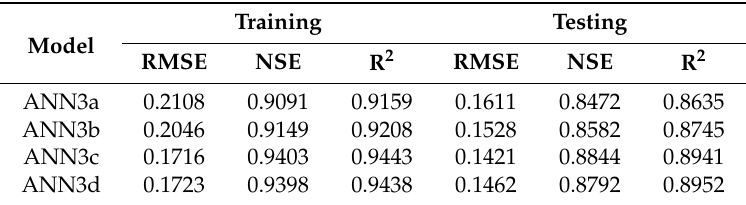
Table 8. Statistical measurement of 3 h forecasts for the entire data set.